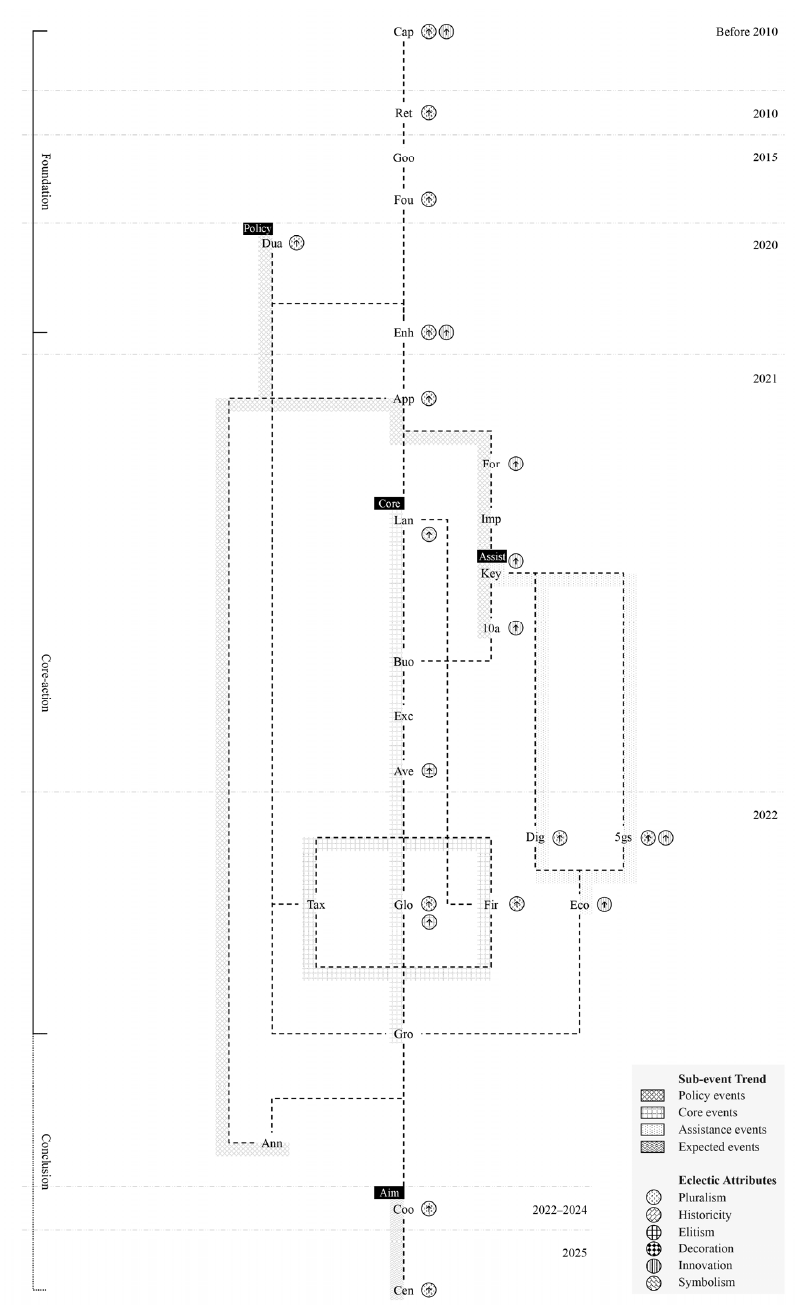
Figure 3. The event structure network model of narrative 1.